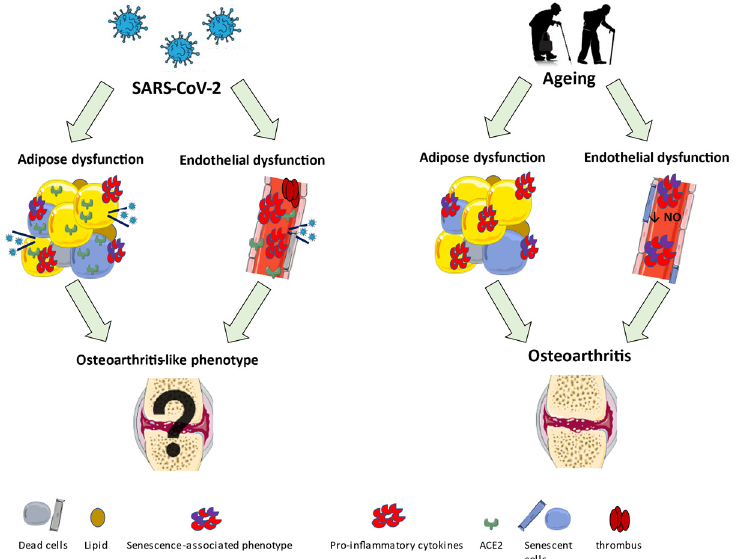
Figure 2. An overview of the early aging alterations in adipose and endothelial tissue due to SARS- CoV-2 infection or ageing.